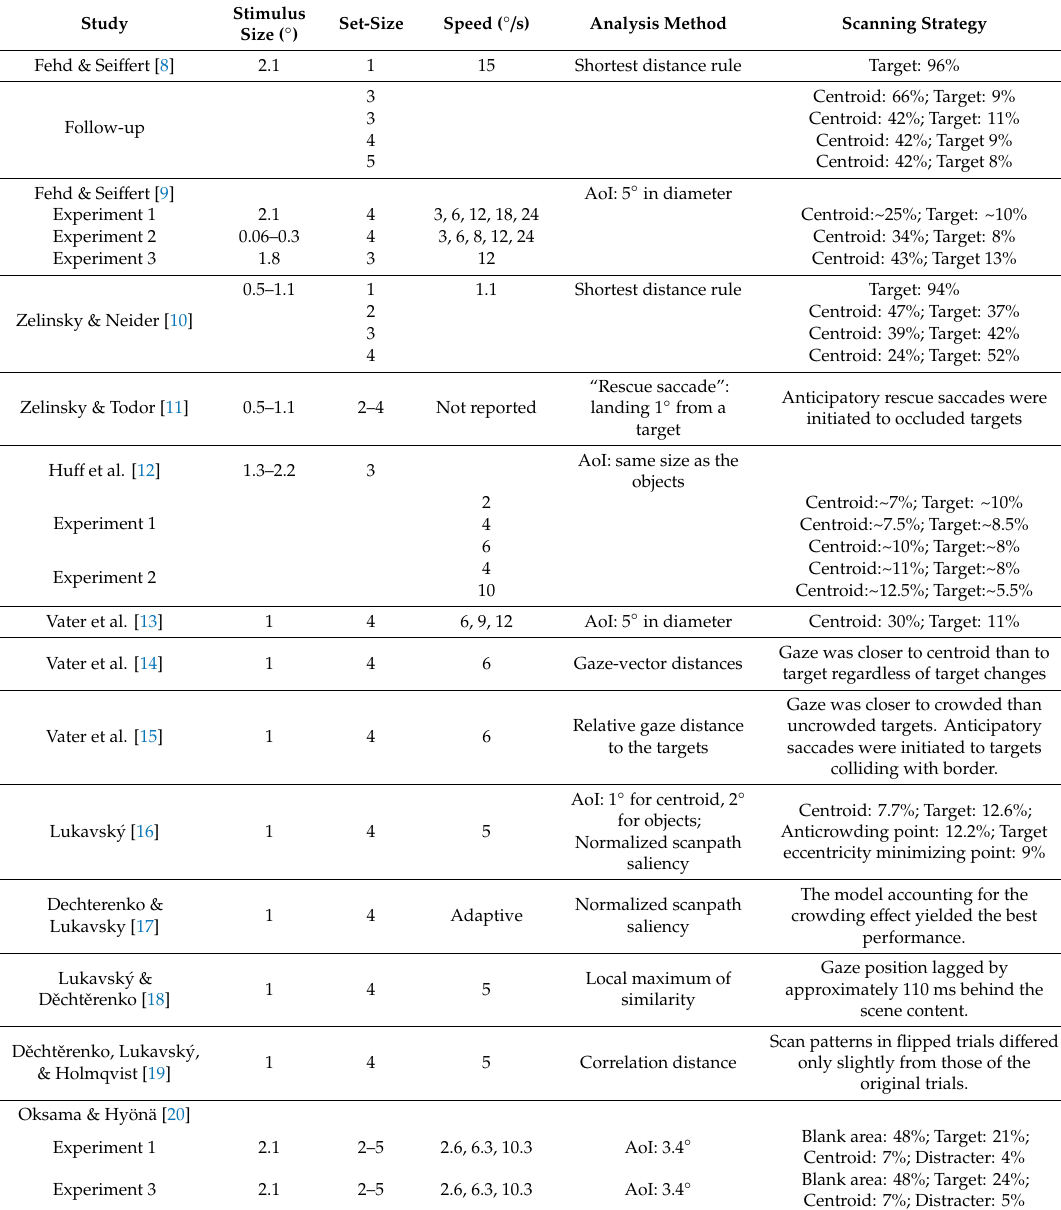
Table 1. Observed scanning strategies in the eye-tracking studies of multiple object tracking